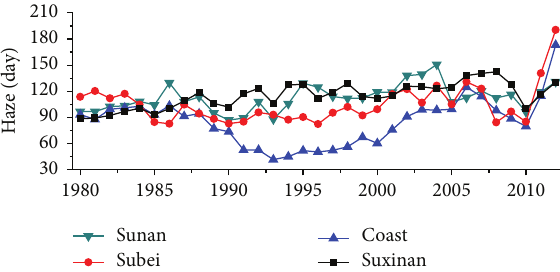
Figure 2: Temporal variability on hazy day in a